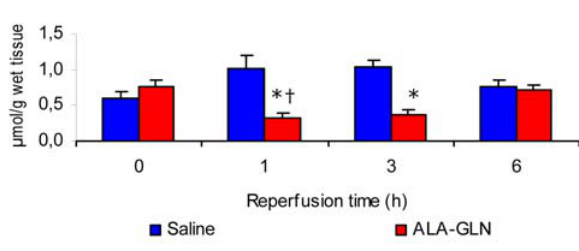
FIGURE 4 - Kidney pyruvate concentrations in saline and L-alanyl-glutamine treated rats.